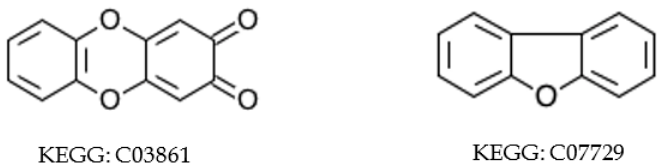
Figure 5. Compound with incomplete KEGG aromatic atom types. The middle ring of compound C03861 ( left ) is not aromatic while the middle ring of compound C07729 ( right ) is aromatic.